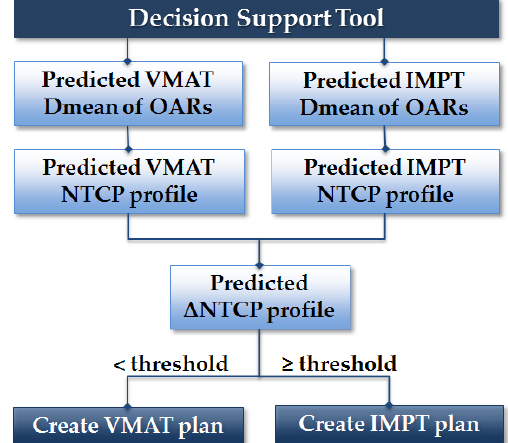
Figure 2. The workflow of the decision support tool.